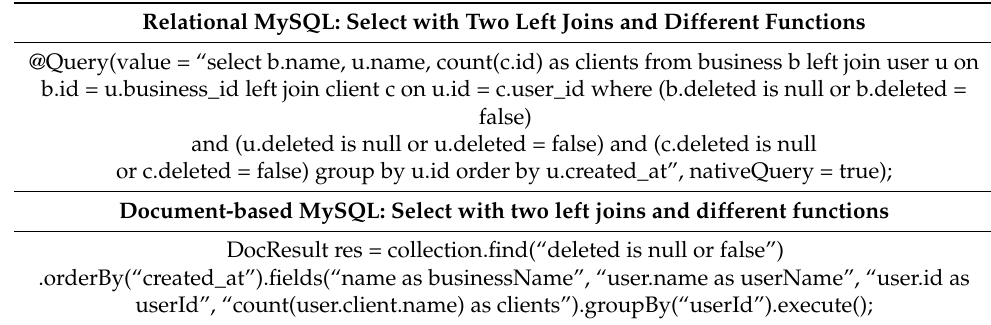
Table 12. Select operation with two left joins and different functions.